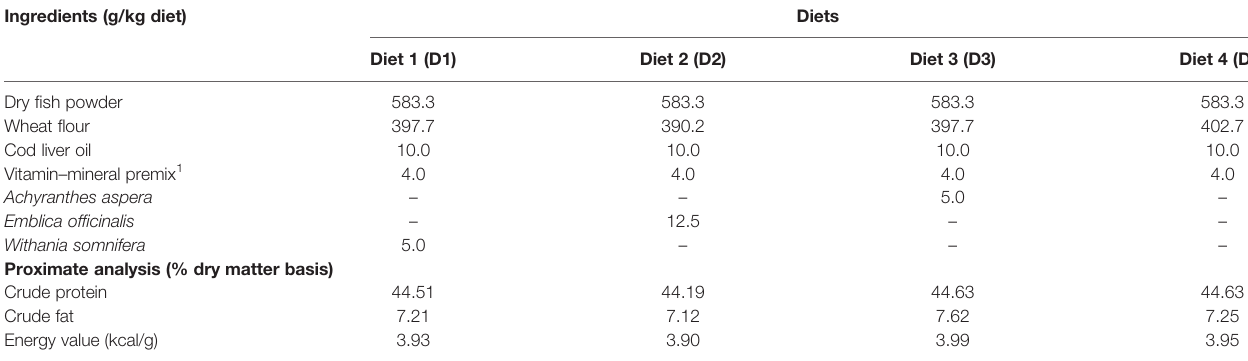
TABLE 1 | Formulations of four different diets and their proximate